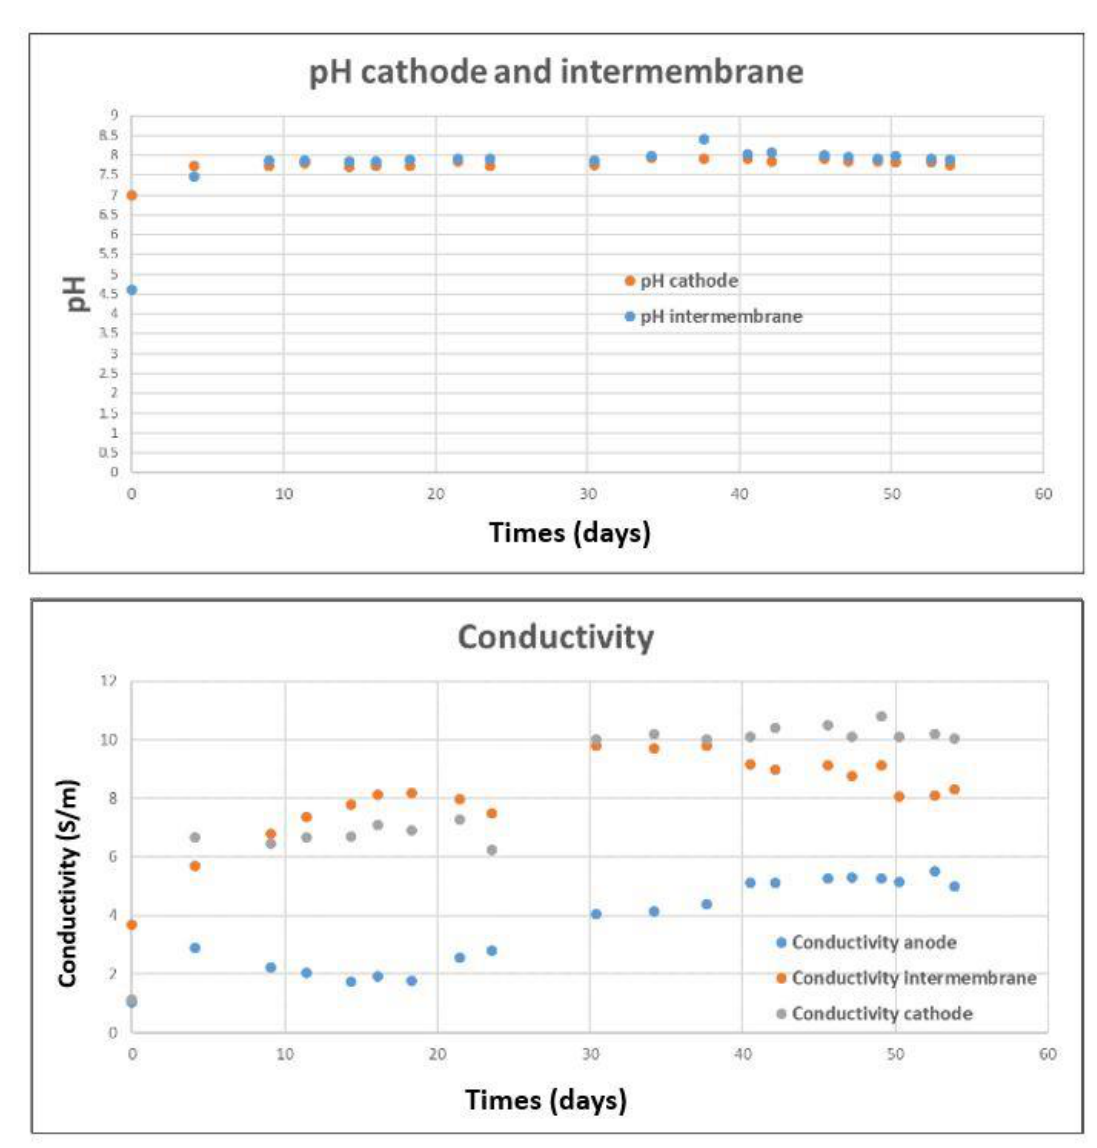
Figure 4. ( a ) pH evolution of IC and CC and, ( b ) conductivity evolution of AC, IC, and CC during Figure 4. pH evolution of IC and CC and, conductivity evolution of AC, IC, and CC during the operation. the